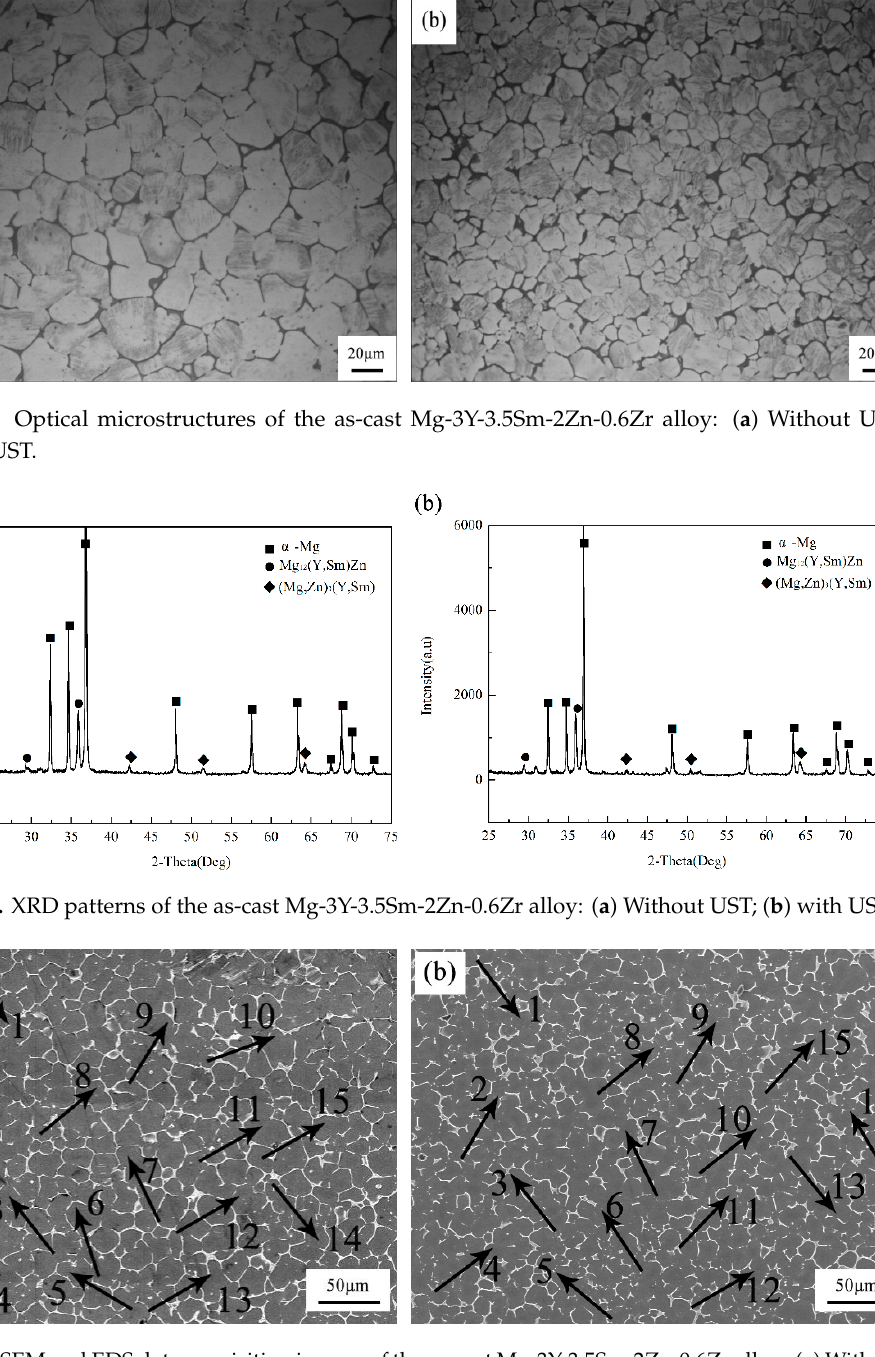
Figure 5. SEM and EDS data acquisition images of the as-cast Mg-3Y-3.5Sm-2Zn-0.6Zr alloy: ( a ) Without UST; ( b ) with UST.